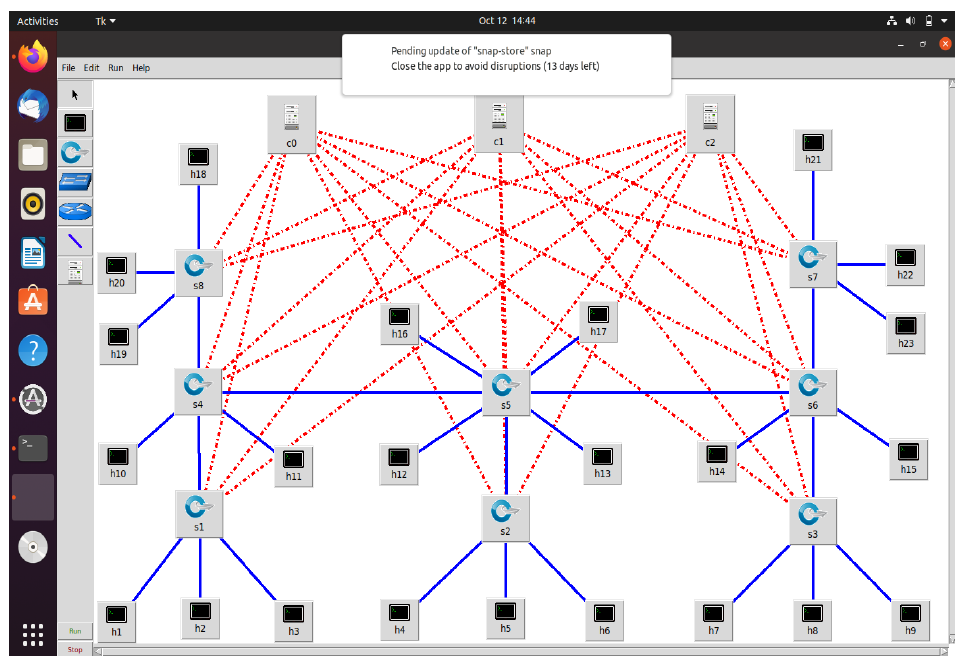
Figure 2. Multi-controller SDN Test Network.